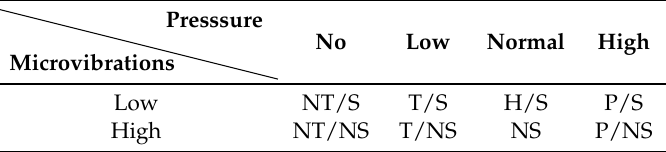
Table 1. Finger fuzzy feedback controller